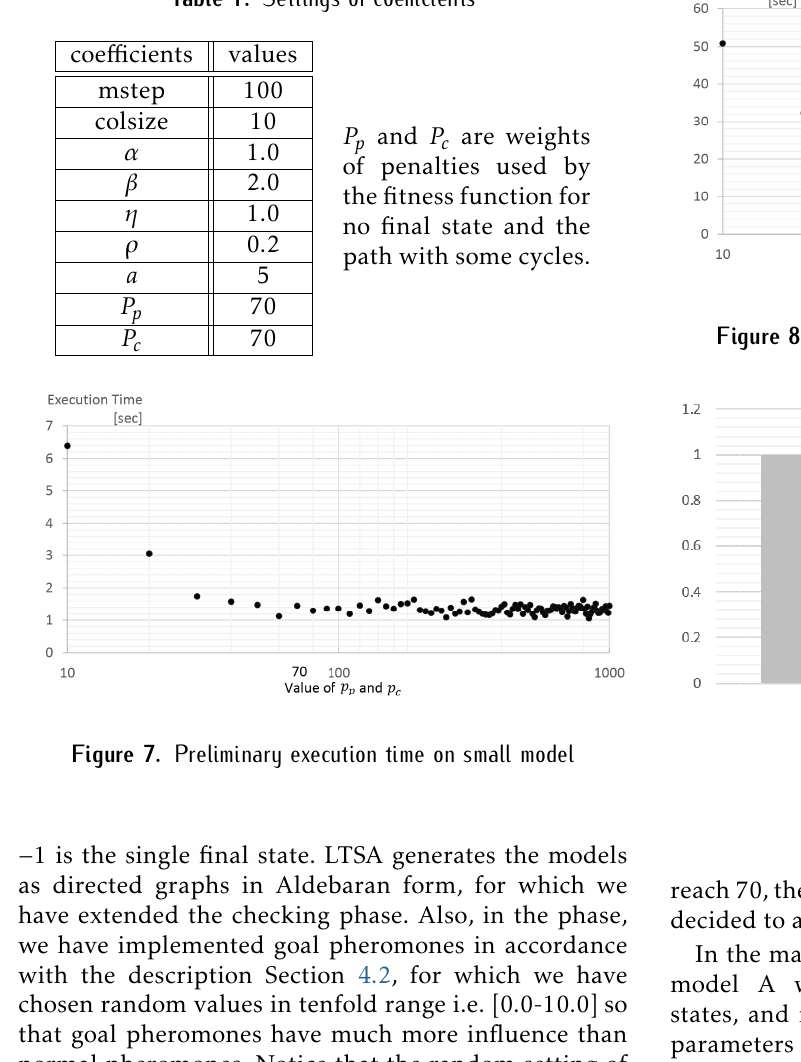
Table 1. Settings of coefficients